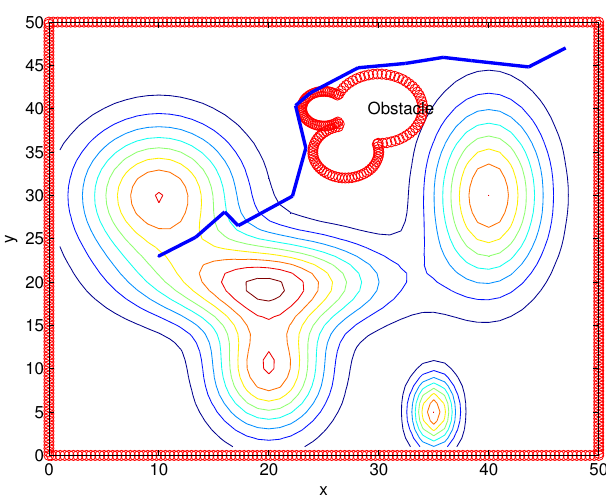
Figure 7. One route constructed under one MC simulation of Algorithm 1 (Scenario 2). A non-convex obstacle is plotted, and we plot the contour map.